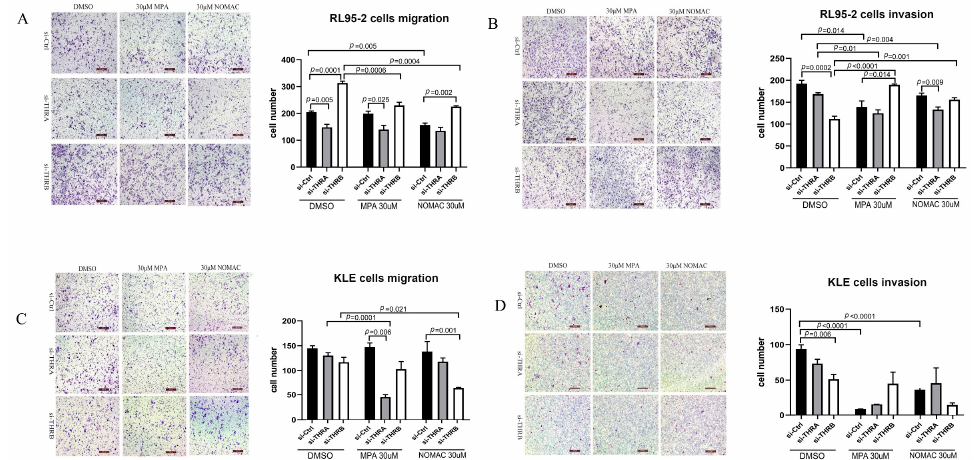
Figure 4. Progestins changed cell migration and invasive abilities in THRB- or THRA-knockdown EC cells. ( A , B ) RL95-2 or ( C , D ) KLE cells were pretreated with si-THRA or si-THRB for 48 h and then incubated in a polycarbonate filter insert containing DMSO, 30 uM MPA, or NOMAc for 12 h to examine the cell migration ( A , C ) and invasion ( B , D ). The results are presented as mean ± SEM of three independent culture experiments. si-Ctrl, negative control treated with siRNA solvent; si-THRA, silenced THRA; si-THRB, silenced